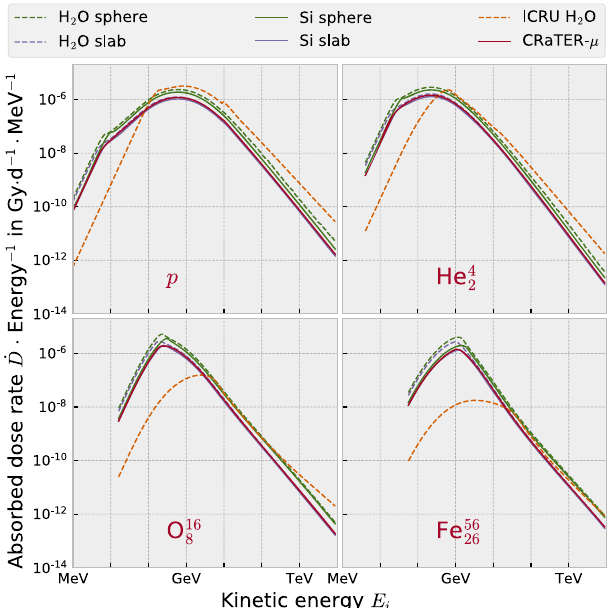
Fig. 4. Absorbed dose in 1 s as a function of energy during solar minimum ( / = 400 MV) is shown here using four panels corresponding to the four selected GCR species, as indicated in the lower center of each panel. Full lines are used for silicon detectors, while dashed lines are used for H 2 O detectors. We observe that the smaller sphere and slab detectors suffer a higher dose at lower energies, while for the low- Z nuclei above 1 GeV, the ICRU detector (phantom) suffers a slightly higher dose.